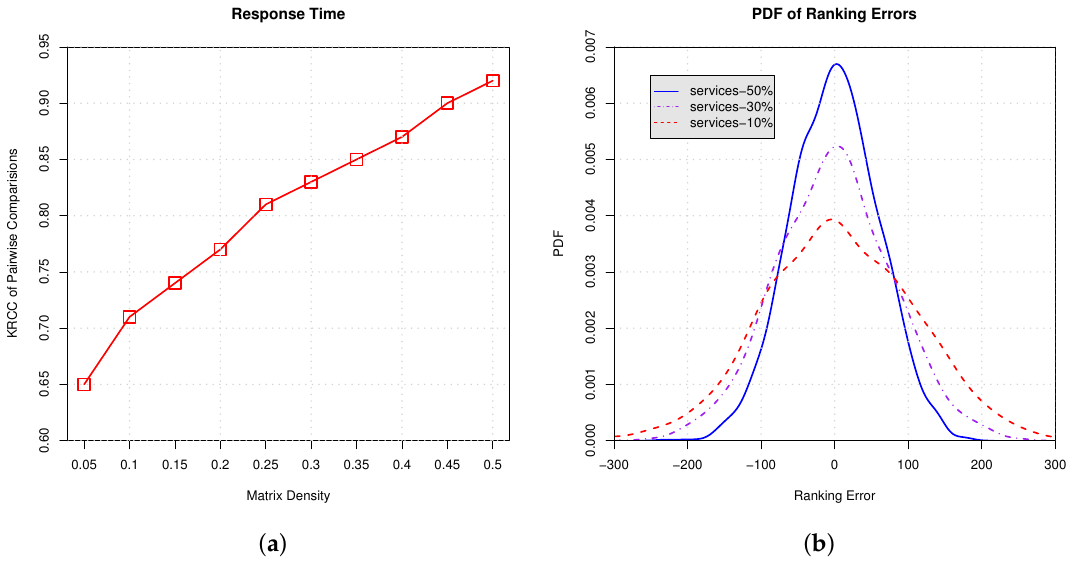
Figure 10. Ranking on response time with different proportions of services selection. ( a ) Kendall rank correlation coefficient (KRCC) of pairwise comparisons; ( b ) Probability density function (PDF) of ranking